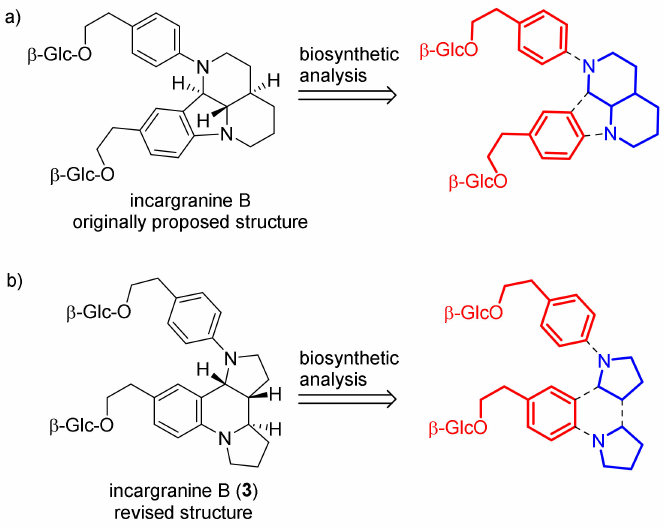
Figure 2. Biosynthetic analysis of incargranine B. ( a ) Originally proposed structure. ( b ) Revised